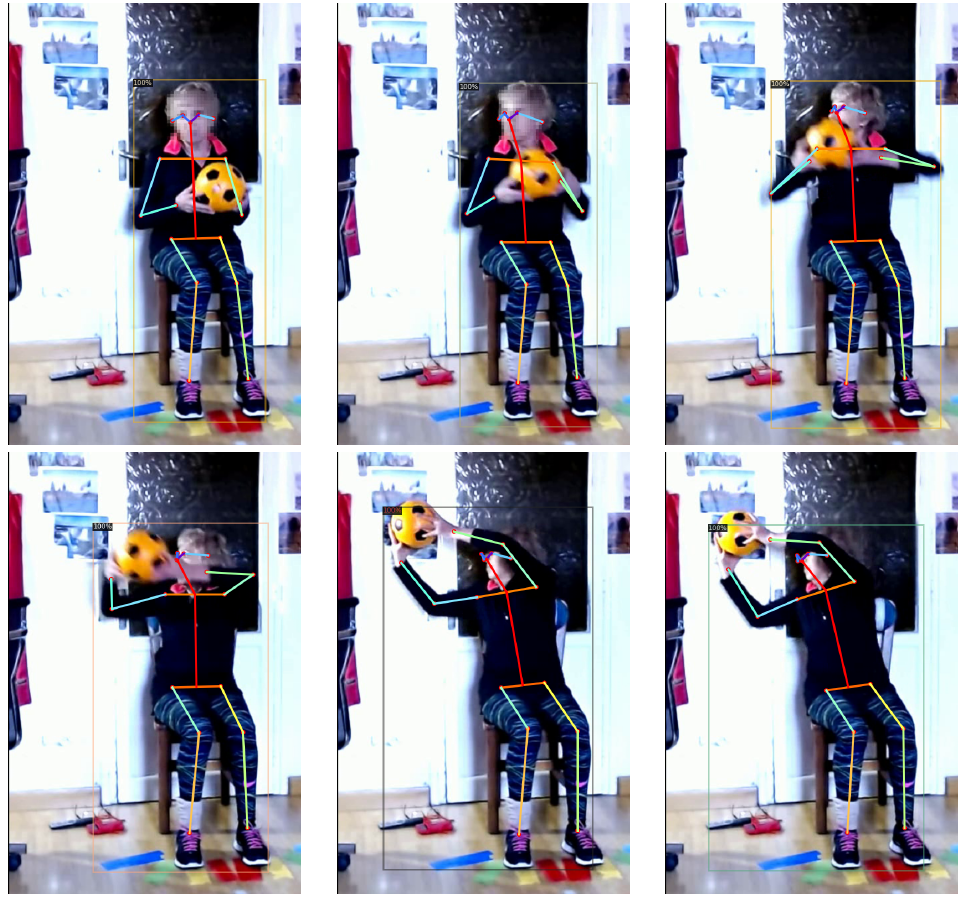
Figure 7. A sequence of six frames of a patient doing an exercise. The frames are anonymized and the skeleton detected by Detectron2 is overlapped on each